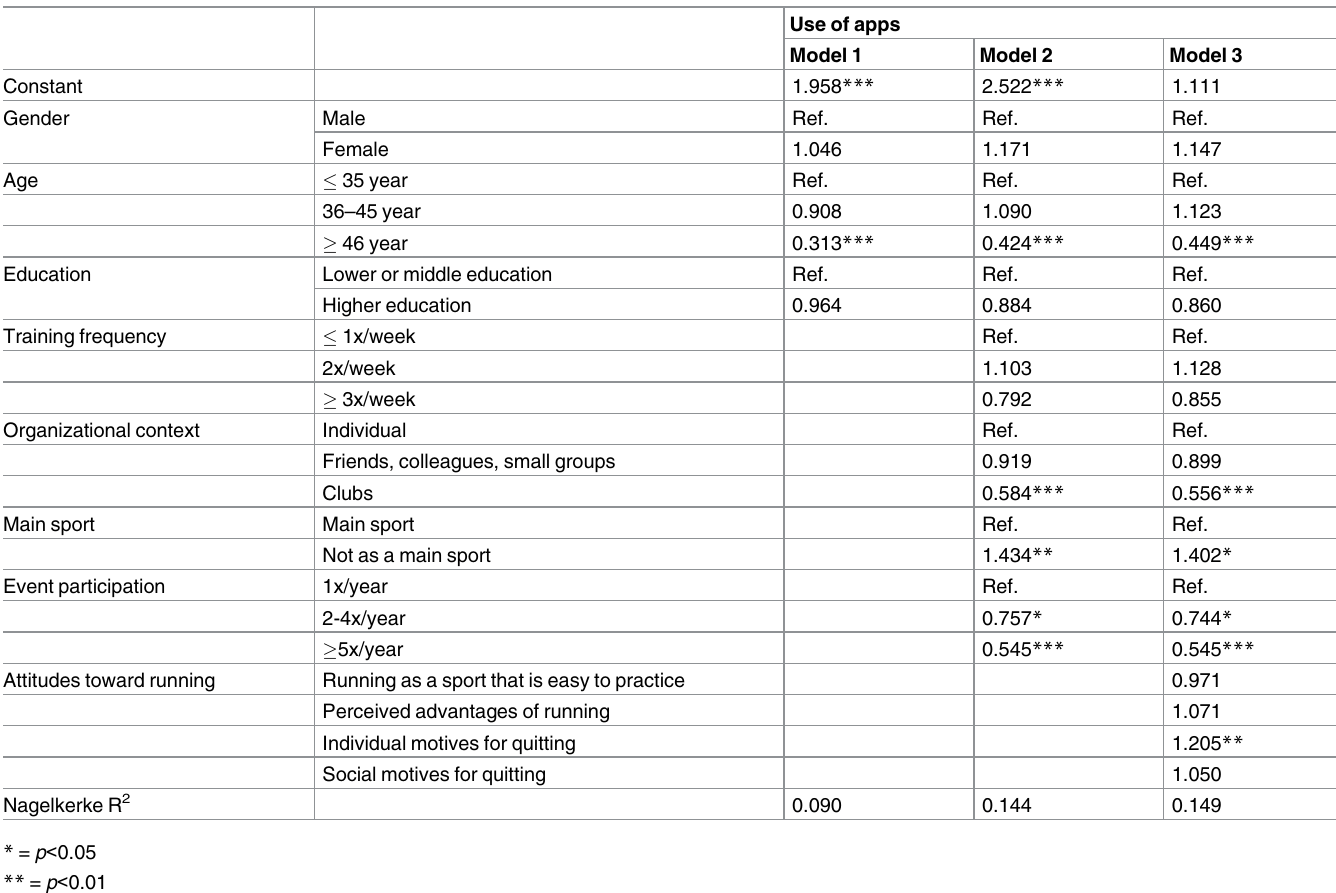
Table 5. Results of the binary logistic regression analysis for event runners’ usage of apps, in odds ratios (Exp ( β )) with regards to the reference group